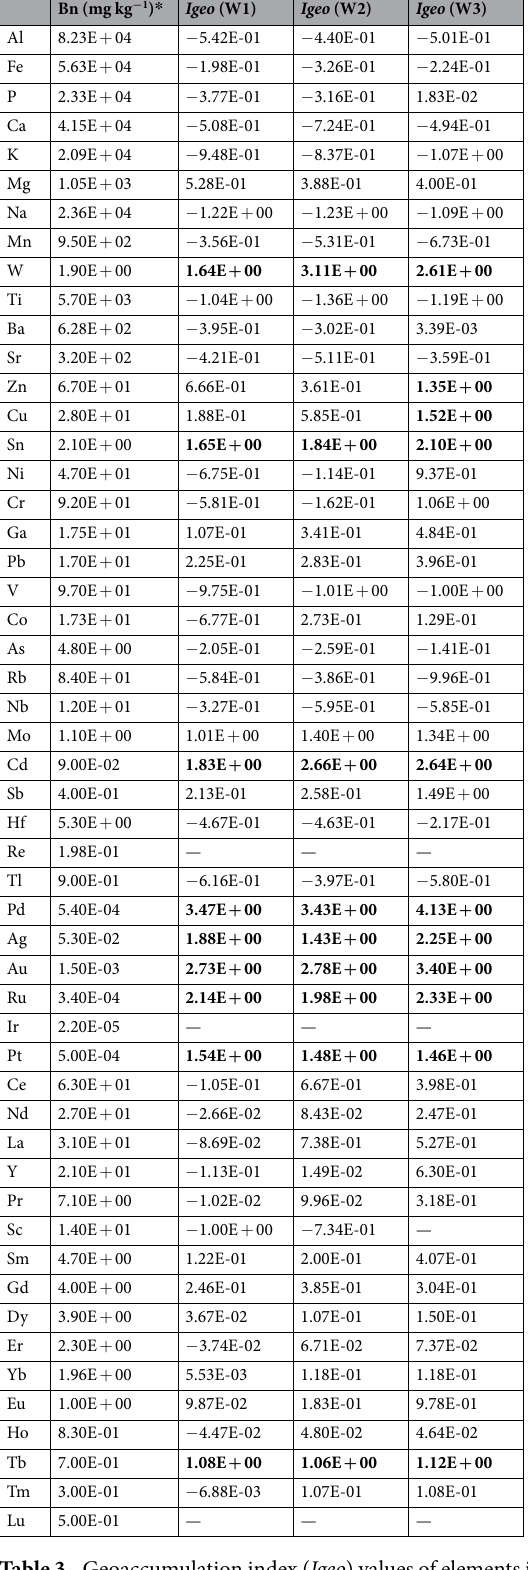
Table 3. Geoaccumulation index ( Igeo ) values of elements in the sludge samples. Bn is the concentration of a given element in upper continental crust; * Concentration from 36, 37